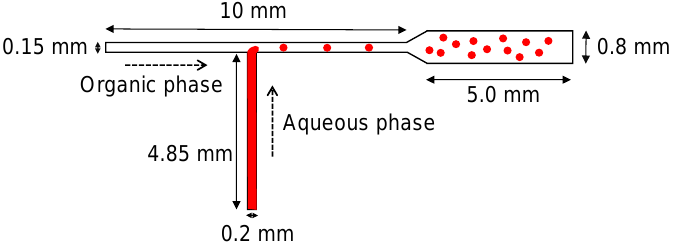
Figure 1. Schematic illustration of microdroplet formation in a T-shaped microfluidic channel.